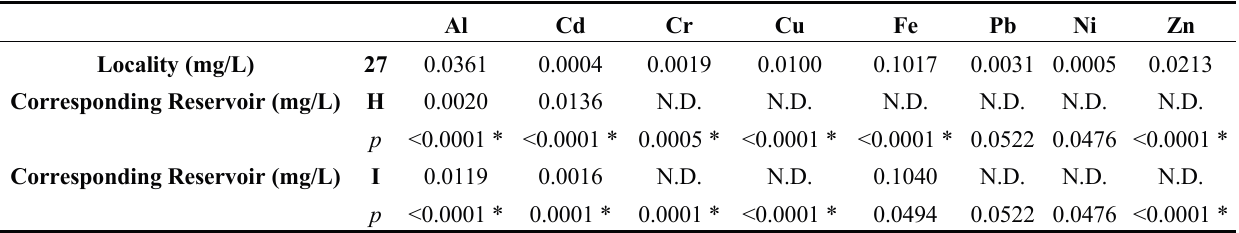
Table A6. Statistical variation between Reservoirs H and I and their feeding Locality 27.